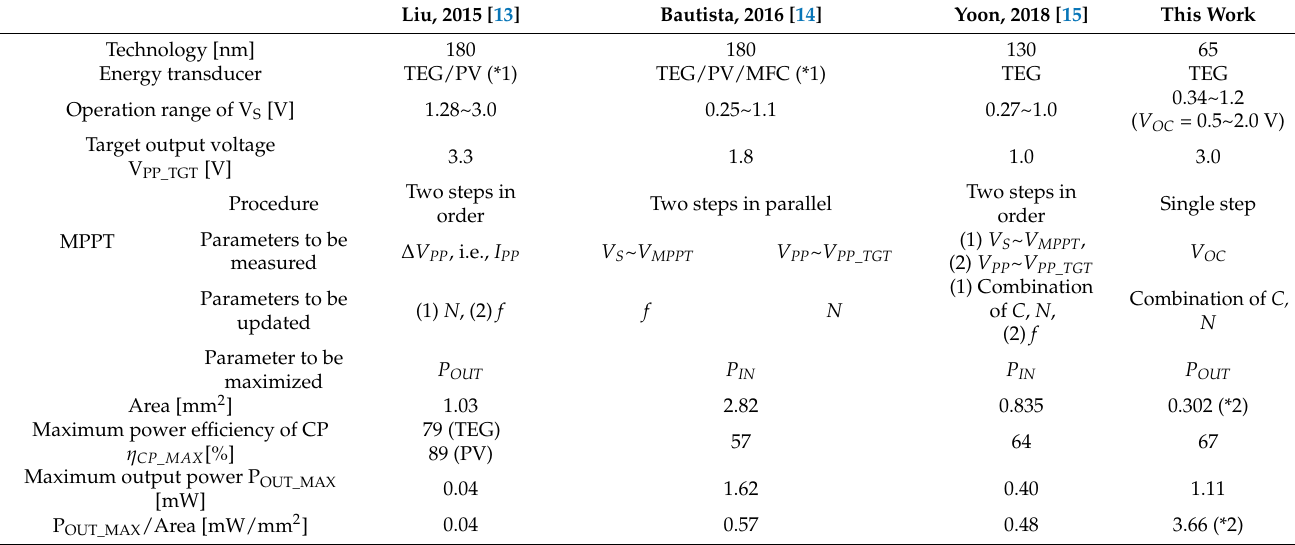
Table 2. Comparison with previous